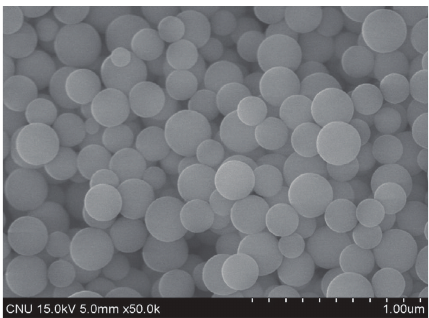
Figure 3: SEM micrograph of ethyl silicate-based nanosilica ( × 50